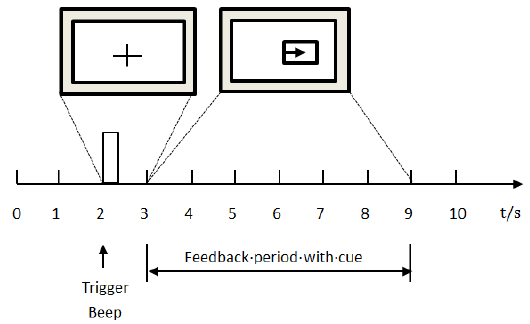
Figure 2. The timing diagram of the collection experiment.